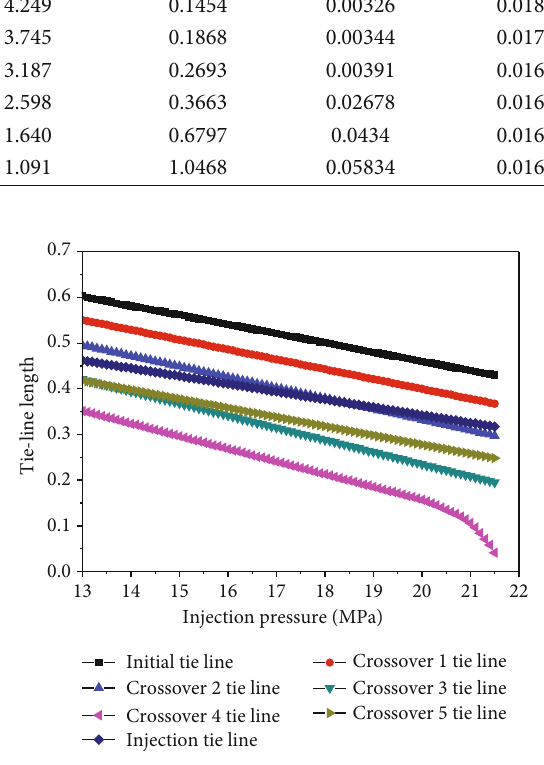
Figure 8: Variation of key tie-line lengths vs. pressure for Case 3. The MMP was estimated to 21.72MPa (3150psia) by our MMC